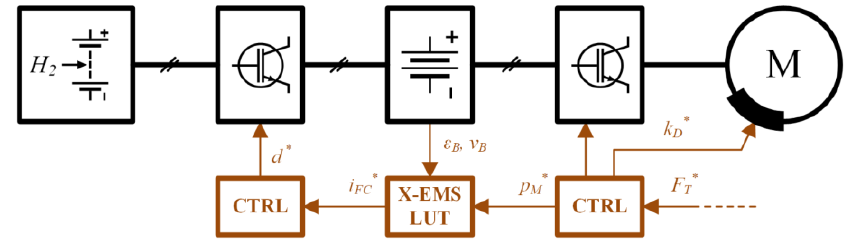
Figure 14. Schematic representation of either S-EMS or A-EMS.